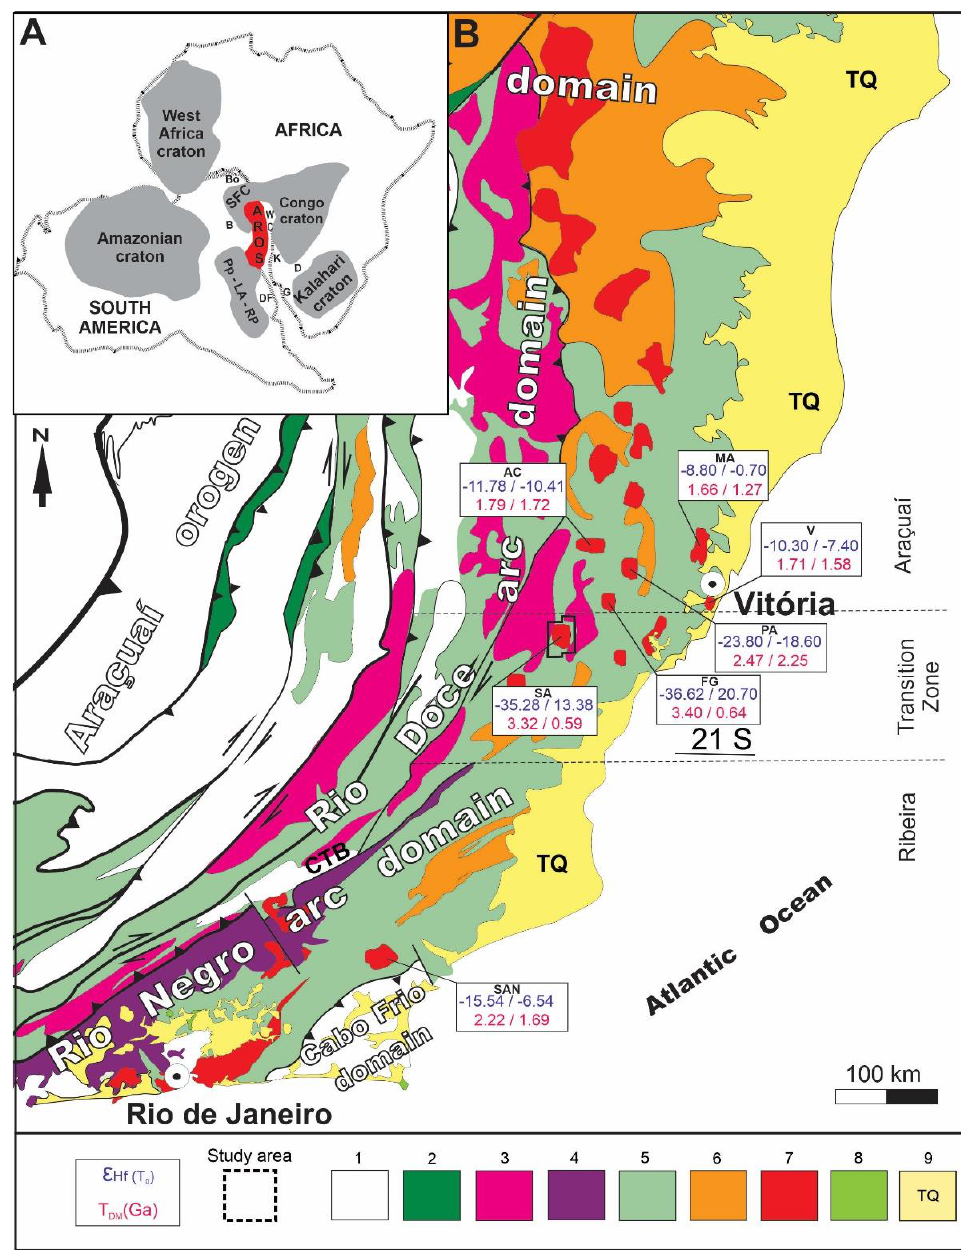
Figure 1. ( A ) Location of the Araçuaí-Ribeira Orogenic System (AROS) in Western Gondwana and the position of the Brasiliano Pan African orogenic belts: B — Brasília; Bo-Borborema; D-Damara; DF- Dom Feliciano; G-Gariep; K-Kaoko; WC-West Congo, and cratons SFC-São Francisco; Pp-LA-RP- Paranapanema-Luís Alves-Rio de La Plata. ( B ) Simplified geological map of AROS adapted from [7,8,32]. Legend: AC-Afonso Cláudio Intrusive Complex; SA-Santa Angélica Intrusive Complex; MA-Mestre Á lvaro Massif; V-Vitória Massif; PA-Pedra Azul-Arecê Intrusive Complex; FG-Forno Grande Intrusive Complex; SAN-Sana granite. LEGEND: 1-Pre-Neoproterozoic units; 2-Neoproterozoic ophiolite-bearing rock assemblages; 3-batholiths and stocks of the Rio Doce magmatic arc (ca. 630 – 585 Ma) and probable correlatives; 4-Rio Negro-Serra da Prata arc domain (Rio Negro and Serra da Prata magmatic arcs and related units; ca. 860 – 630 Ma); 5-Neoproterozoic metasedimentary and metavulcanic successions; 6-granitic collisional rocks (ca. 590 – 535 Ma); 7-post-collisional intrusions (ca. 525 – 470 Ma); 8-Cenozoic Alkaline magmatism; 9-Cenozoic cover (TQ); CTB: Central Tectonic Boundary. The Lu-Hf isotopic data presented in the figure were obtained in this work [31,34,39 – 41].